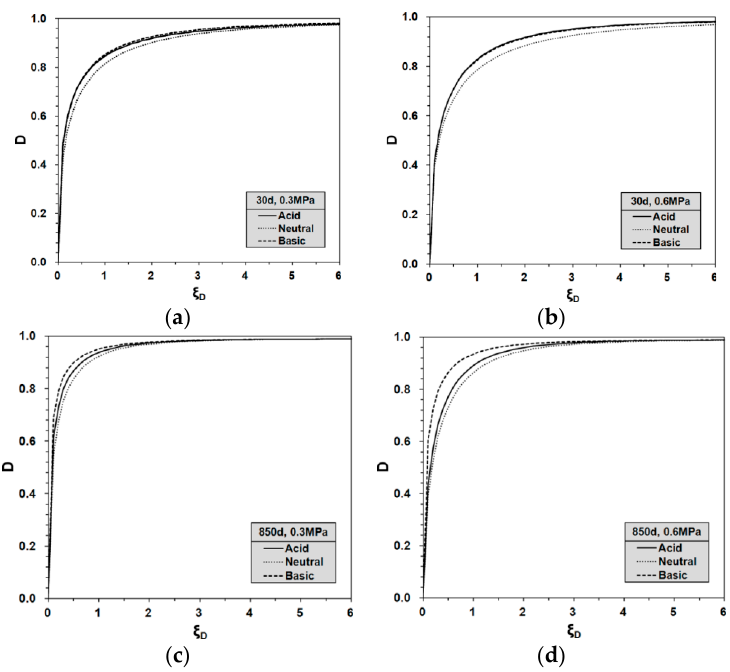
Figure 10. New disturbance function curves: ( a ) 30 days submersion, 0.3 MPa; ( b ) 30 days submersion, 0.6 MPa; ( c ) 850 days submersion, 0.3 MPa; and ( d ) 850 days submersion, 0.6 MPa.